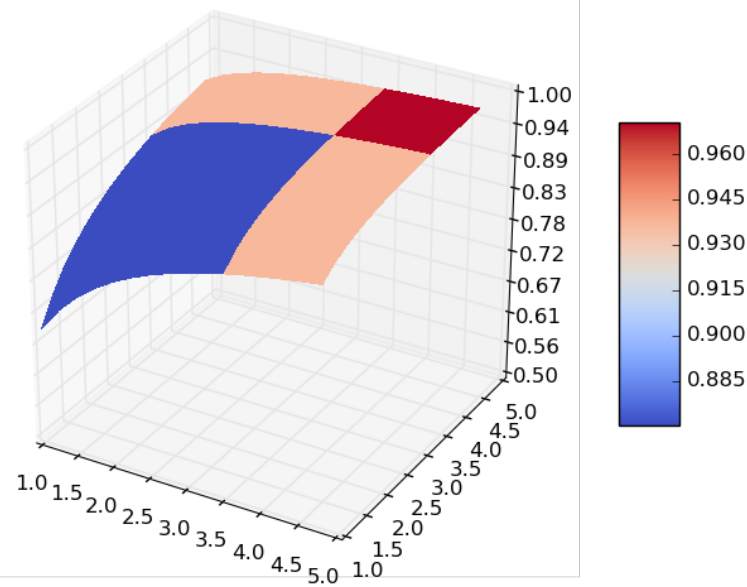
Figure 2. Smoothing of Φ A , D